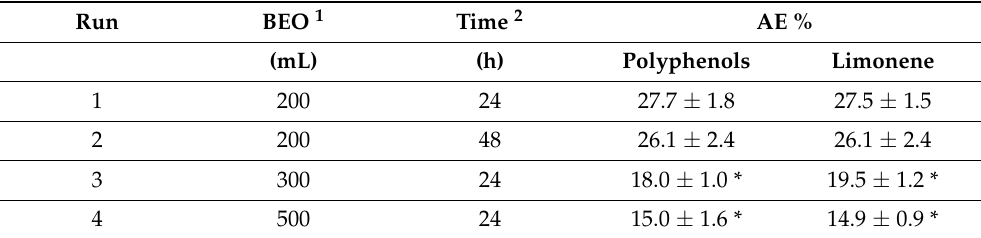
Table 1. AE % values for BEO/MCD complexes, obtained by varying the complexation conditions in presence of 10 mg of MCD. Mean ± SD, n = 3.